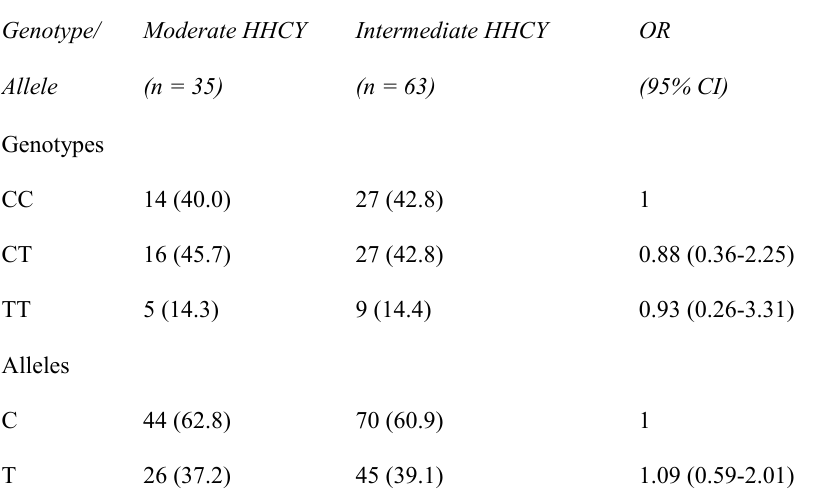
Table 3. Genotype and allele frequency of the MTHFR (677 C → T) polymorphism among moderate- and inter- mediate HHcy patients with cardiovascular disease